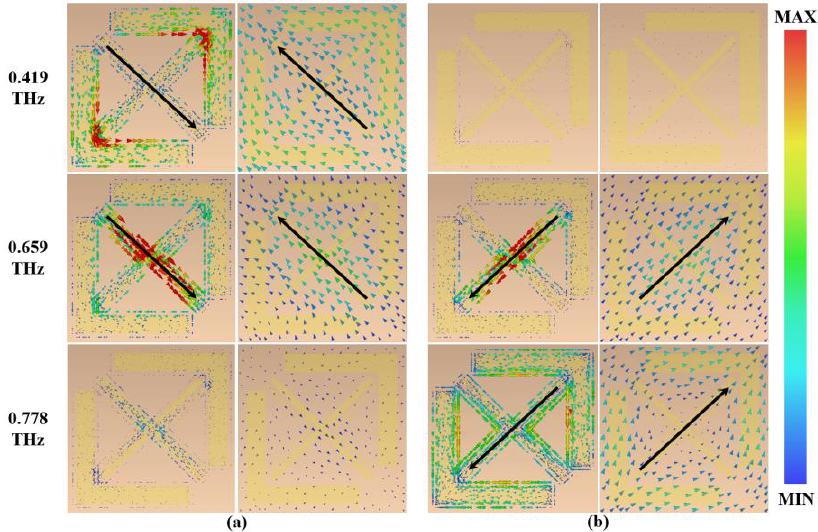
Figure 8. ( a ) Current distribution of the I-side metamaterial under v-polarization; ( b ) current distri- bution of the I-side metamaterial under u-polarization.